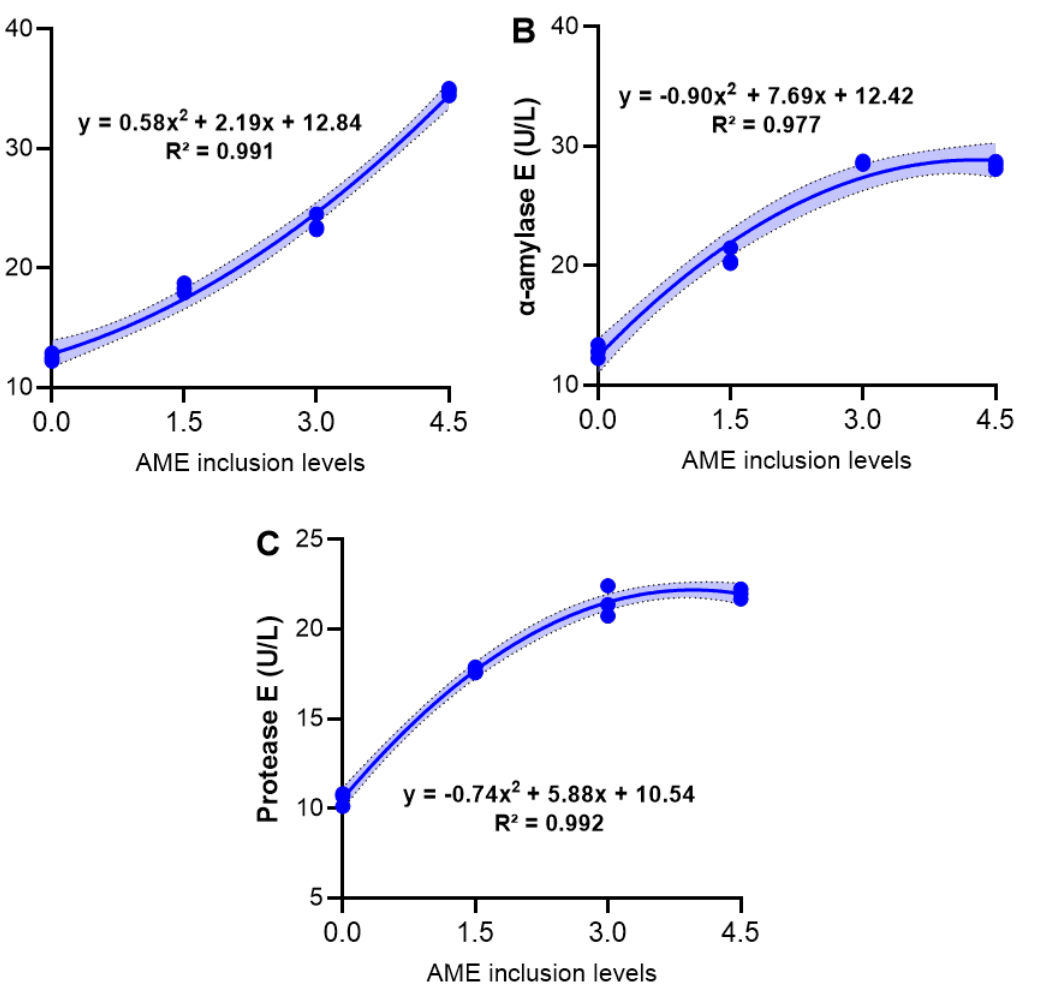
Figure 2. Serum lipase E ( A ), α -amylase E ( B ), and protease E ( C ) of juvenile P. hypophthalmus fed diets with different AME inclusion levels over the feeding trial period of 56 days. Data lines denote best fit models for the data. Equations and R square in the figures demonstrate the relationship between the measured parameters and AME inclusion levels. Individual marker indicates the number of technical replicates (n = 3). Individual marker is the mean of two biological replicates.